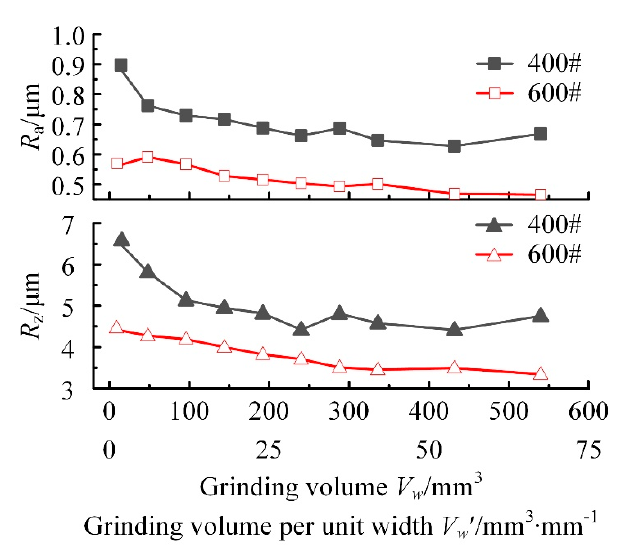
Figure 7. Effect of grinding wheel wear on surface roughness. Figure 7. E ff ect of grinding wheel wear on surface